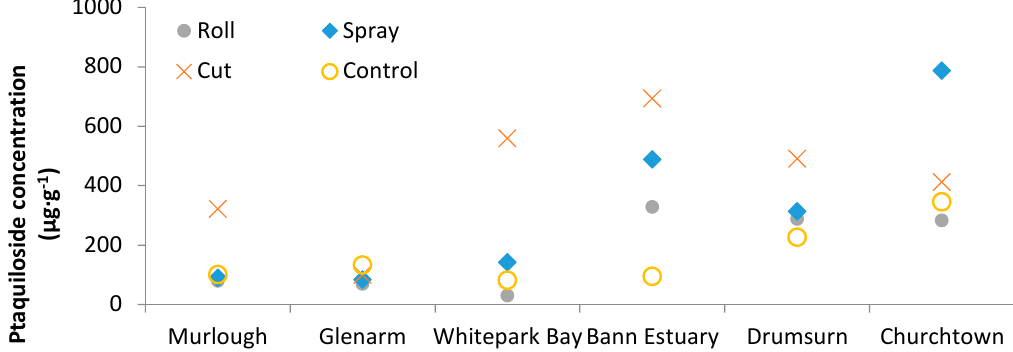
Figure 7. Ptaquiloside concentrations in bracken fronds at the 6 sites in Northern Ireland, UK, after treatment (roll, cut, spray).